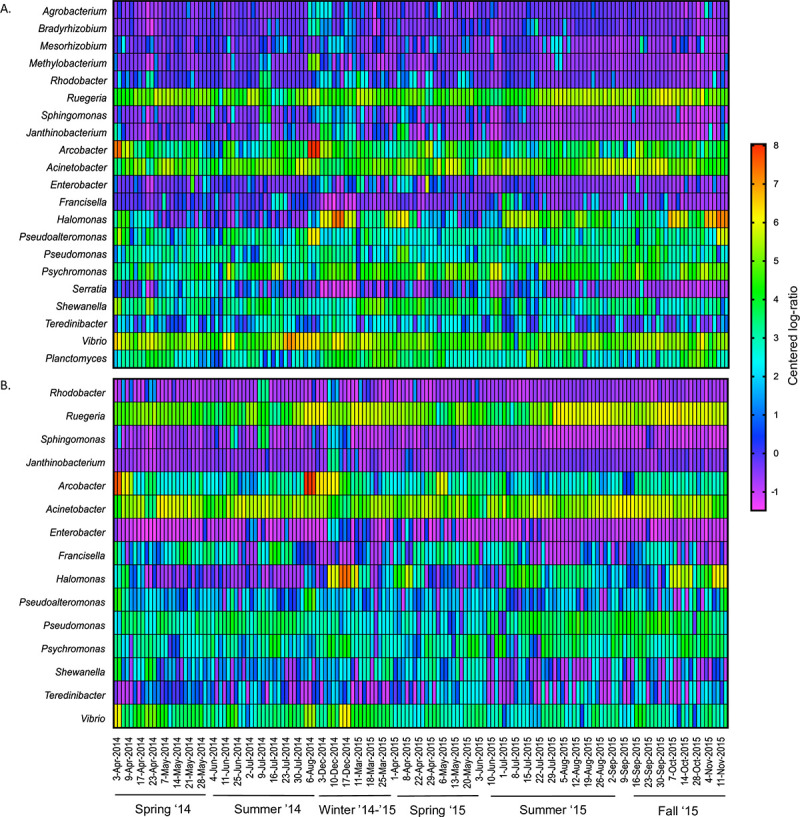
Heatmap profile showing the abundance of various T6SS-bearing bacterial genera from 2014–2015 samples.(A) Particle-attached (3.0 μm) filter size fraction. (B) Free-living (0.2 μm) filter size fraction. OTU abundance relative to per-sample geometric mean is based on clr transformed values of sequence reads belonging to each bacterial genus across duplicate or triplicate samples.